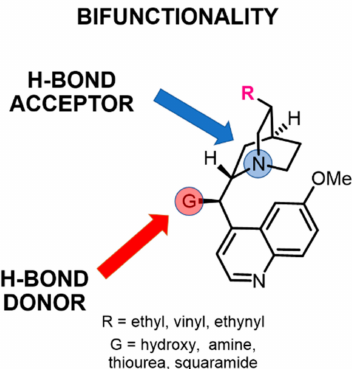
Figure 5. The bifunctional sites of the represented cinchona